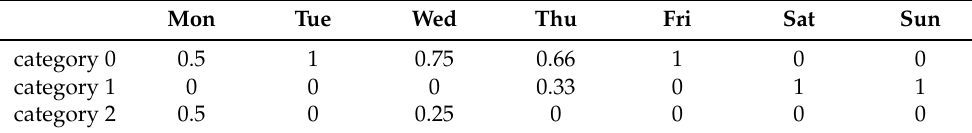
Table 5. Category probability statistics of KPI time series data sub-sequences.